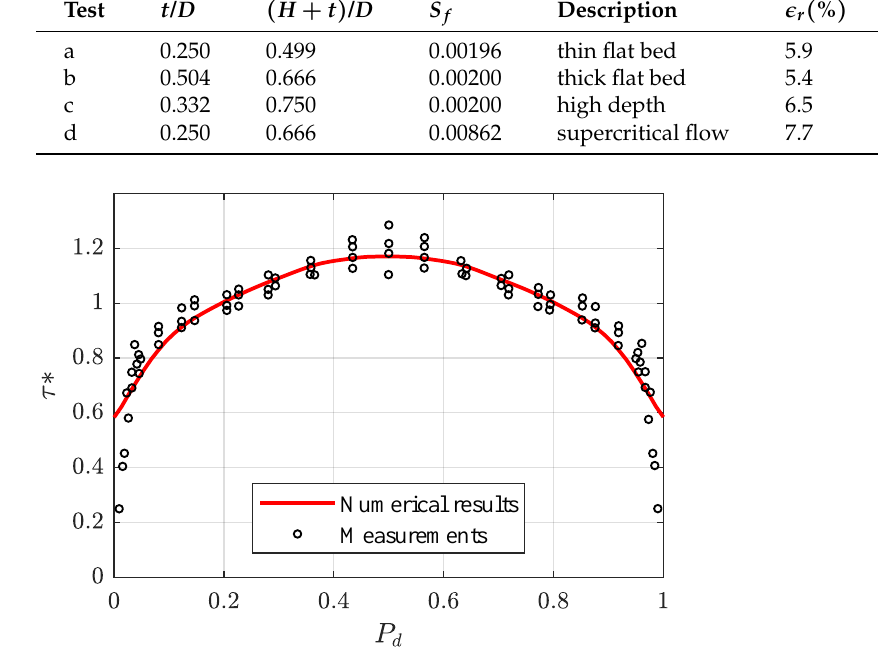
Figure 11. Comparison of calculated and measured boundary shear stress distributions in a rough circular conduit of the experiments of Replogle and Chow [32].